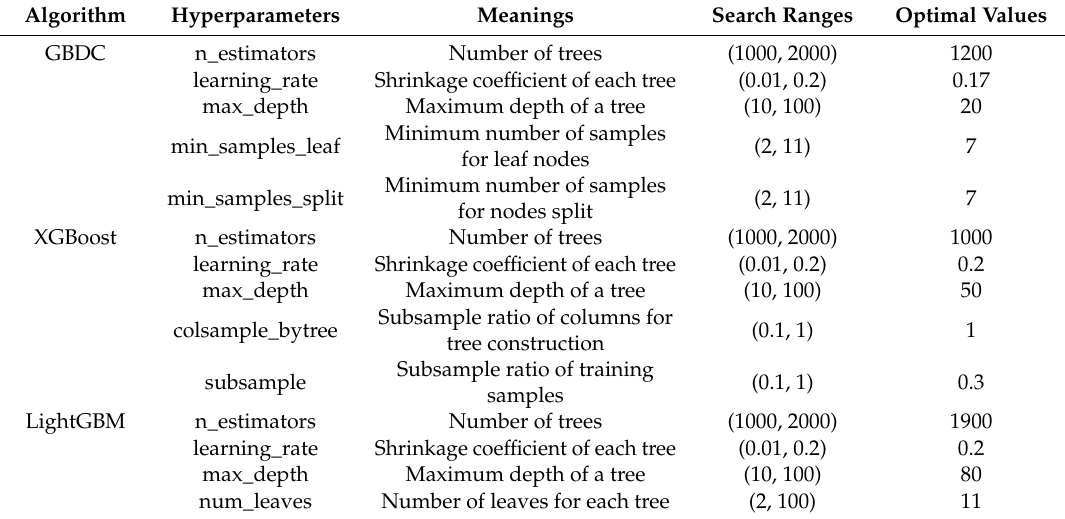
Table 3. Hyperparameters optimization results.